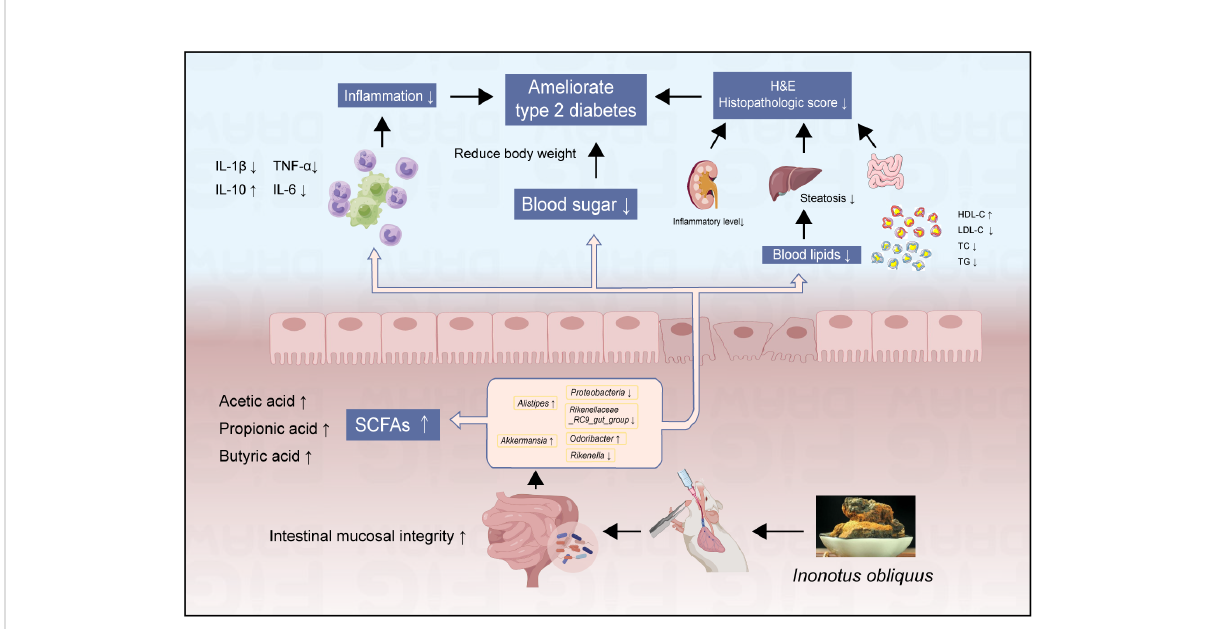
FIGURE 8 The effects of Inonotus obliquus on db/db